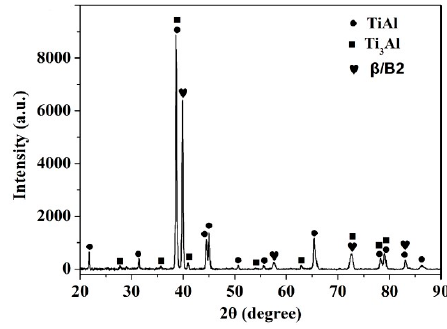
Figure 2. XRD pattern of the as-forged Ti-43Al-9V-0.2Y alloy.